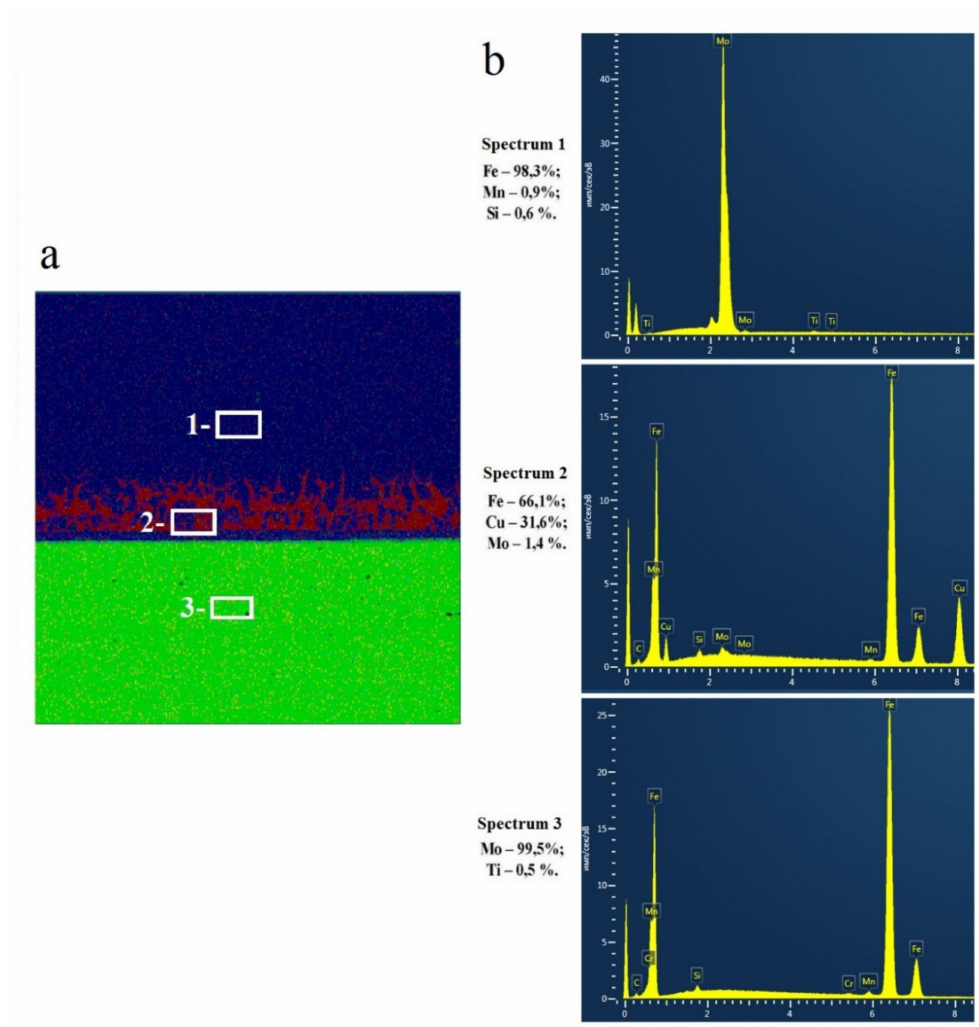
Figure 10. ( a ) EDX elements distribution map of Mo (green), Cu (red) and Fe (blue) in a traditionally brazed part; ( b ) spectra